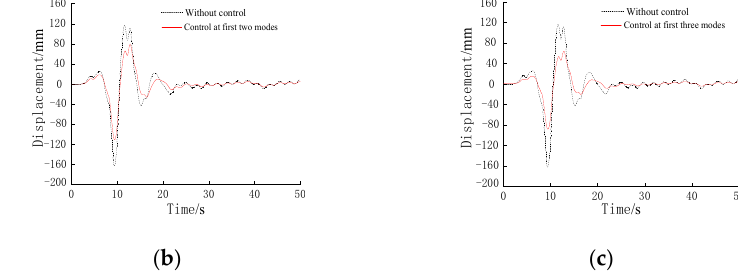
Figure 20. Time history of acceleration by optimized control at different modes under the Jiangyou seismic record. ( a ) First mode. ( b ) First two modes. ( c ) First three modes.